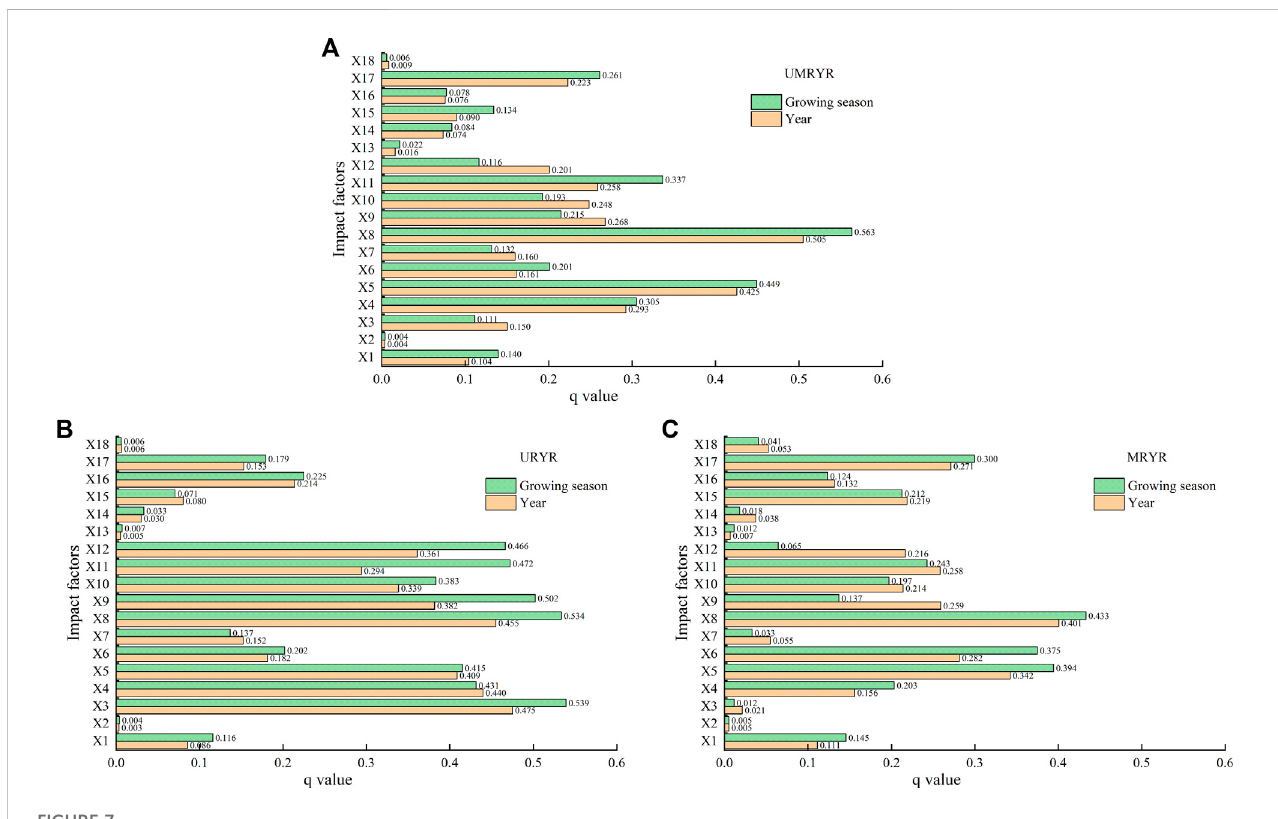
FIGURE 7 Detection factor q values [ (A) UMRYR; (B) URYR; (C)